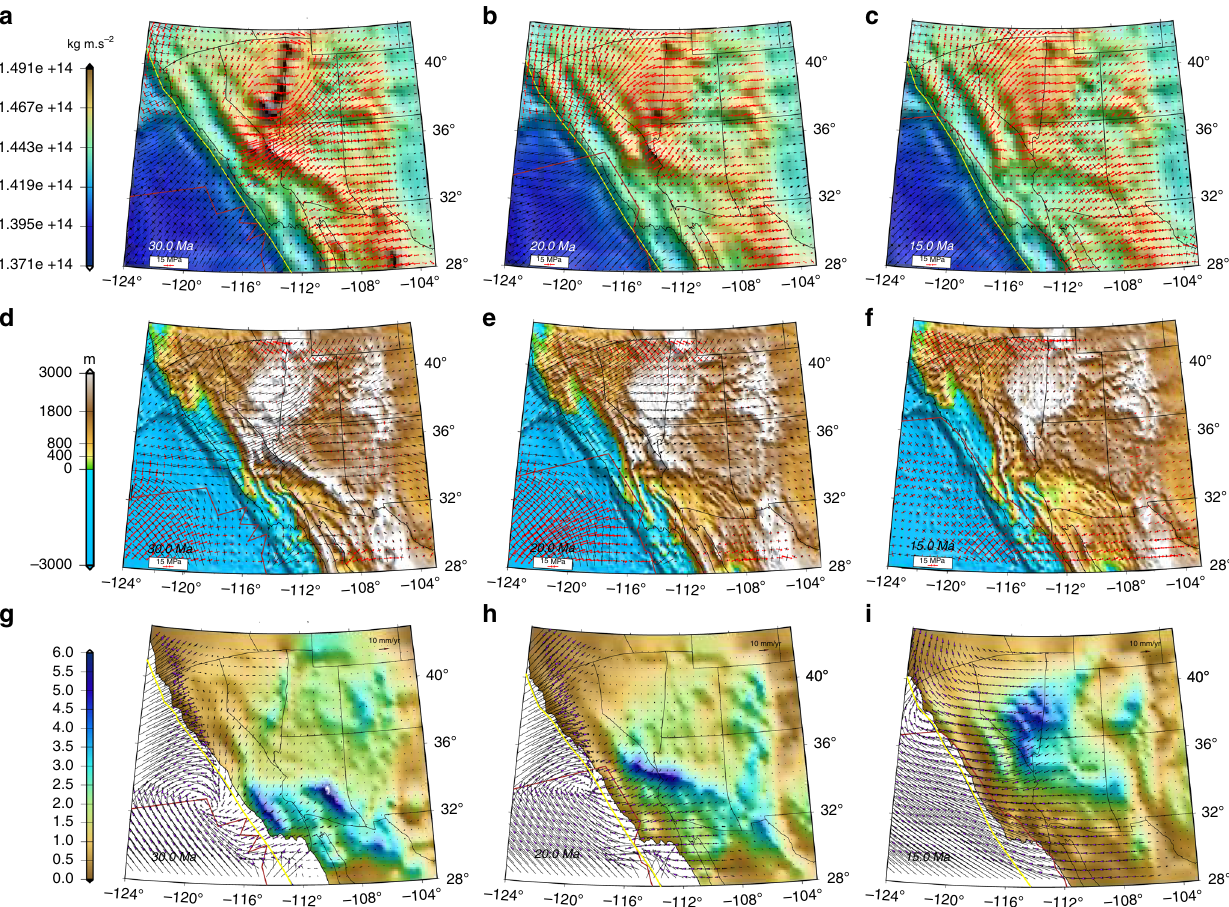
Fig. 7 Depth integrated horizontal deviatoric stresses associated with GPE differences and boundary condition forces. a – c Time-slice maps of contoured GPE estimates in southwestern North America. Arrows represent vertically averaged horizontal deviatoric stress fi eld associated with GPE variations within the lithosphere. d – f Time-slice maps of the stress fi eld boundary condition superimposed on paleo-elevation model of Bahadori et al. 8 . Red arrows represent tensional principal axes of deviatoric stress, and black arrows represent compressional principal axes of deviatoric stress tensors. g – i Time-slice maps of ratio of T GPE / T BCS . Purple vectors are model dynamic velocities relative to North America. Red line in all panels represents reconstructed position of the East Paci fi c Rise and San Andreas Fault System. Yellow line in all panels represents reconstructed position of continental